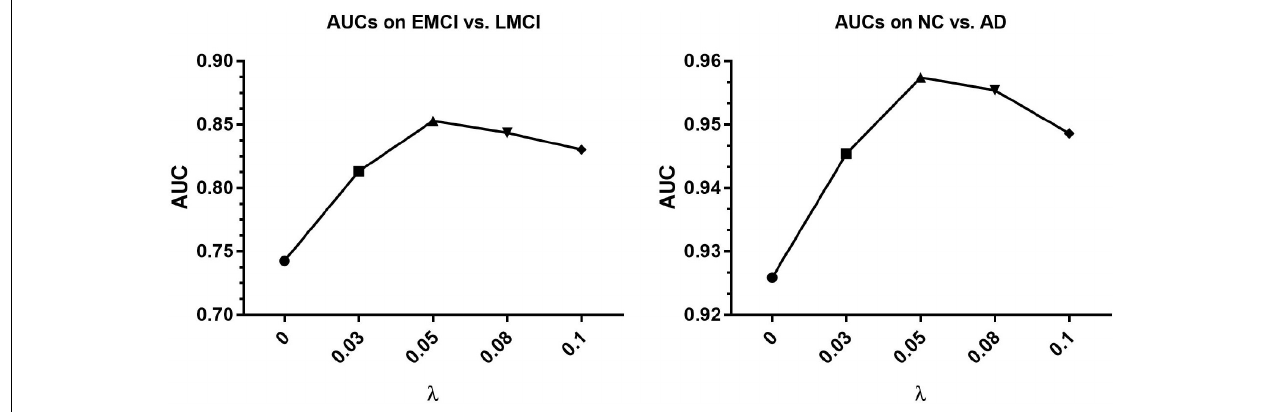
FIGURE 4 | The AUCs of ablation experiments loss functions for EMCI vs. LMCI classification and NC vs. AD classification based on the Schaefer et al. (2018) atlas. AUC, area under the receiver operating characteristic